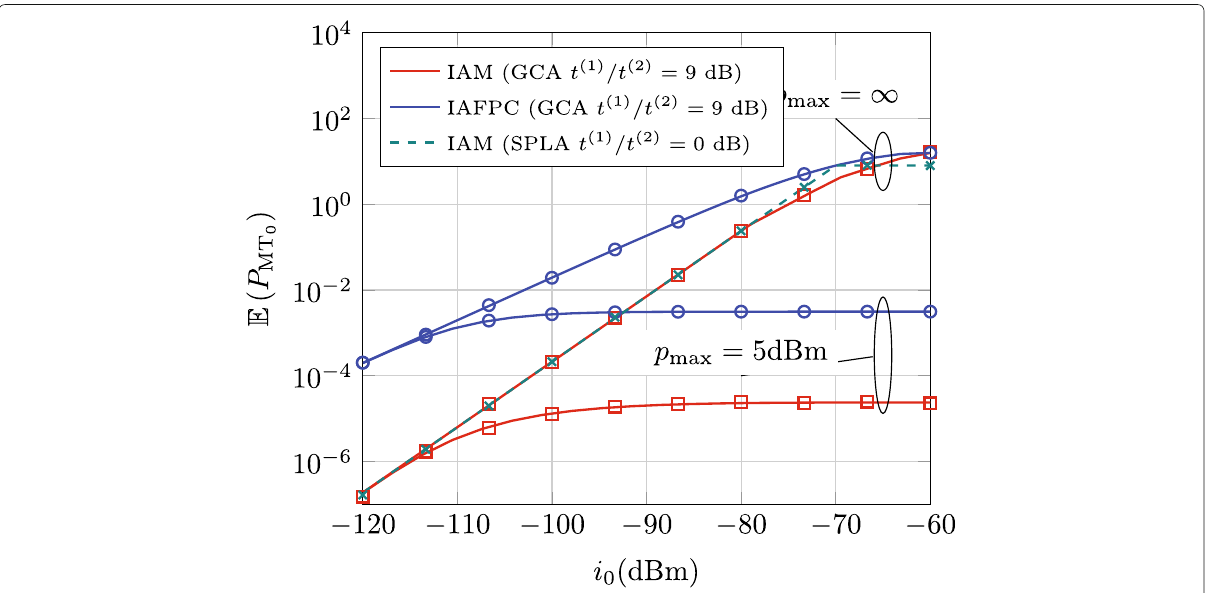
Fig. 1 Average transmit power versus i 0 for IAM and IAFPC methods with (cid:5) = 1, p max → ∞ , and p max = 5 dBm